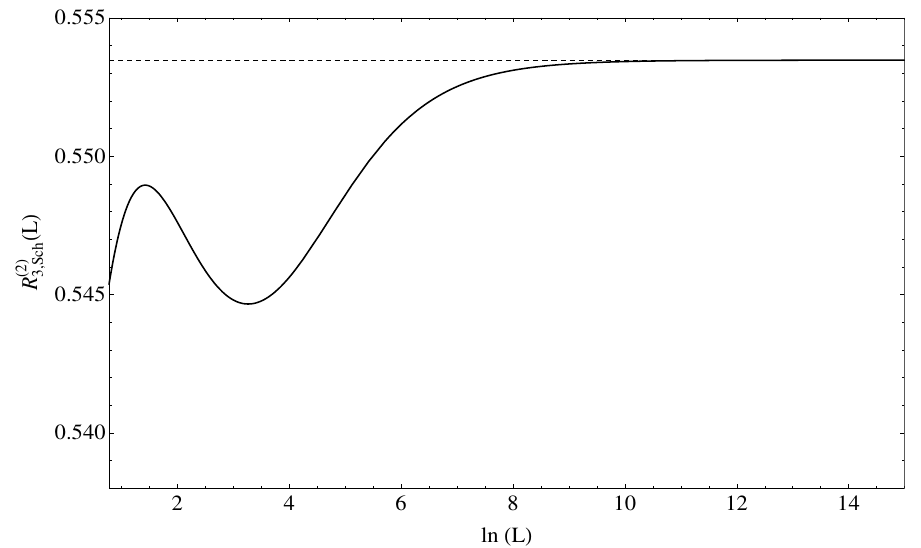
Figure 8 . Plot of the function R (2) ( L ) shown as the continuous line. The dashed line represents 3 ; Sch the asymptotic value 0 : 5534 obtained in reference [1].